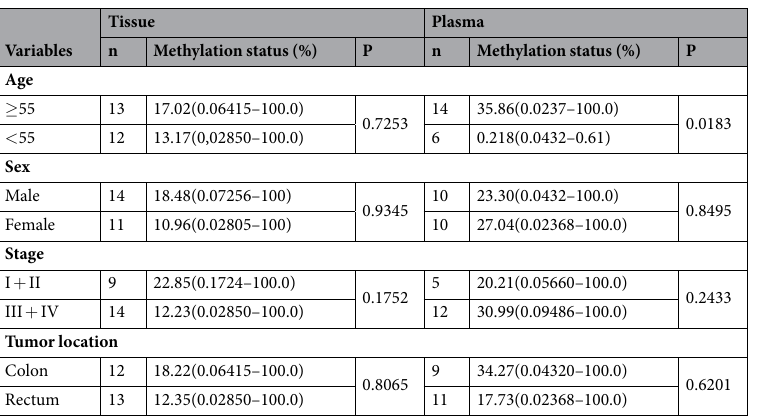
Table 2. Association between clinicopathologic characteristics and PCDH18 methylation